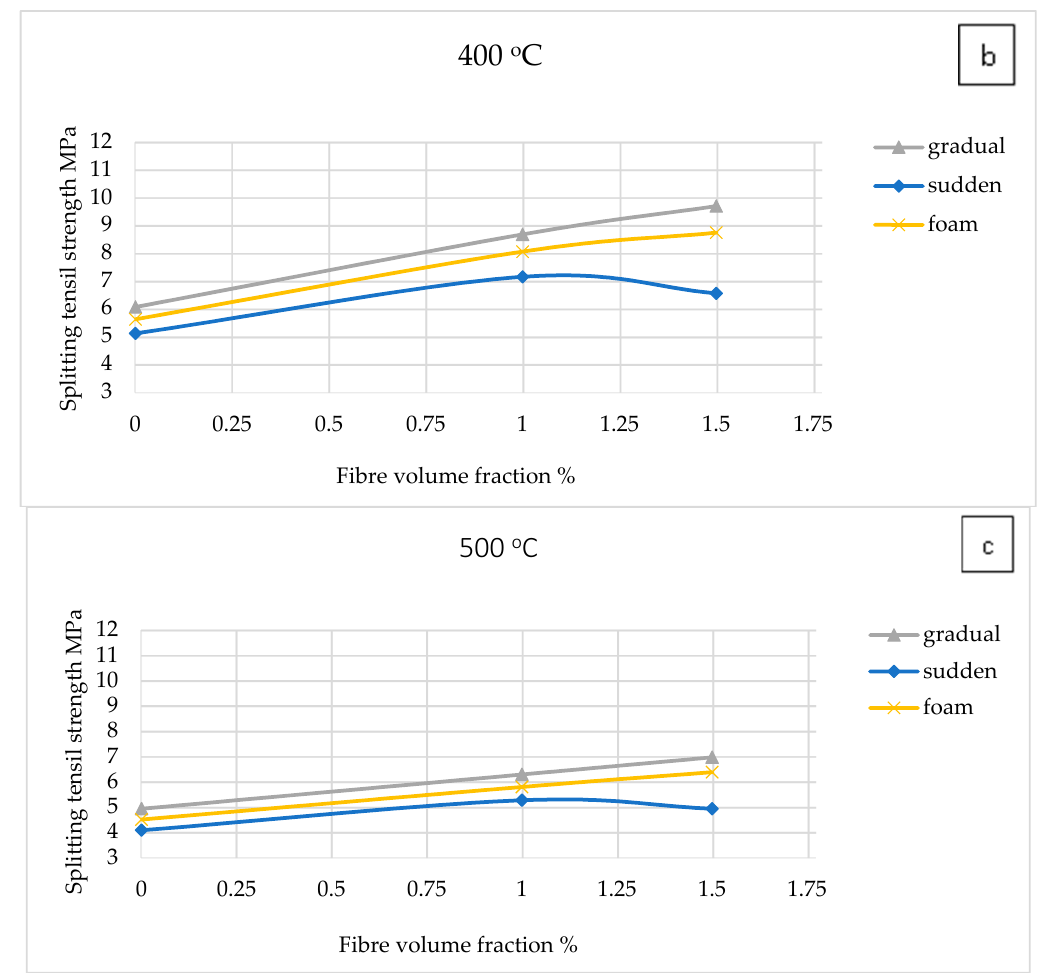
Figure 9. Splitting tensile strength for various (RPC) specimens and cooling methods: ( a ) At burning temperature 300 °C; ( b ) At burning temperature 400 °C; and ( c ) At burning temperature 500 °C.